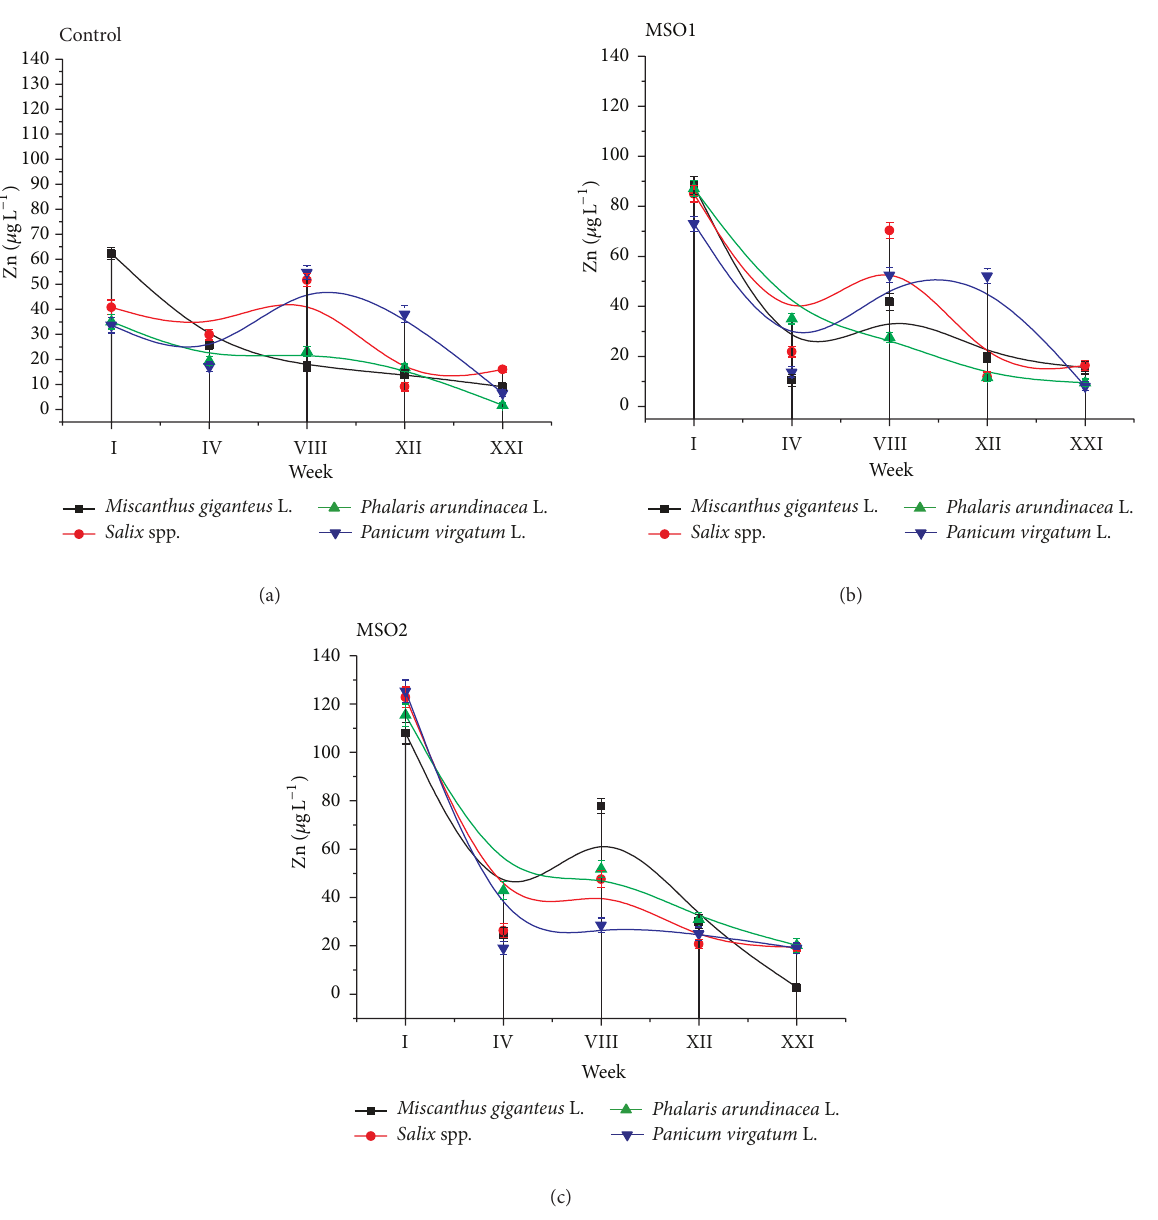
Figure 3: The content of Zn ions in soil leachate after the application of Trichoderma -based materials (MSO1 and MSO2).